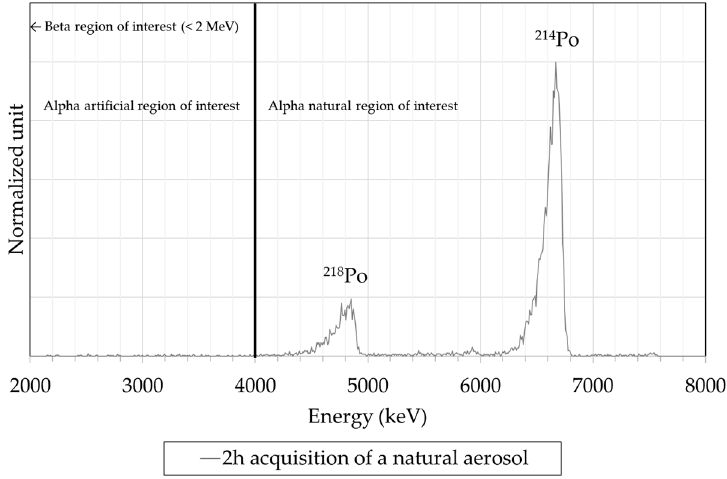
Figure 2. Illustration of a CAM radiation measurement. It shows the two regions of interest, one for artificial alpha and one for natural alpha. A third one dedicated to the beta, below 2 MeV, is not highlighted here because it is not relevant.